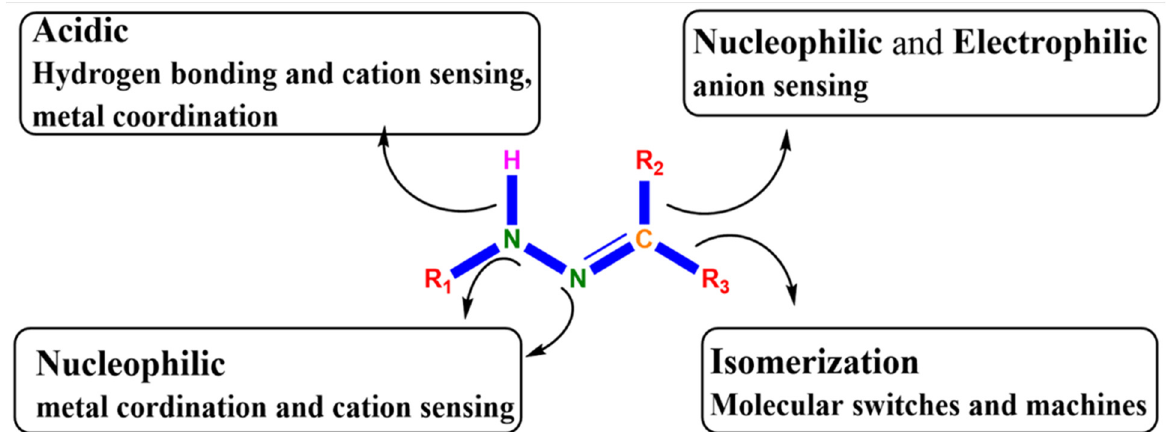
Figure 1. The structural and functional diversity of hydrazine scaffold